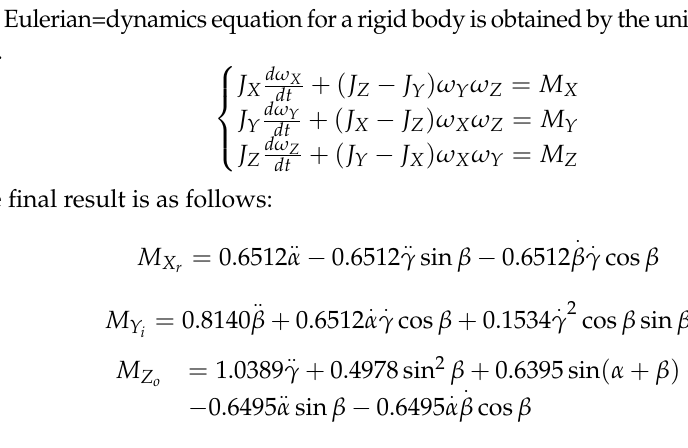
Table 1. Approximate moments of inertia of the three axes relative to each axis of rotation. Rotational Inertia J/(kg.mm 2 ) X -axis Y -axis Z -axis Roll axis 0.6512 0.6495 0.6295 Pitch axis 0.1657 0.1635 0.3191 Yaw axis / /